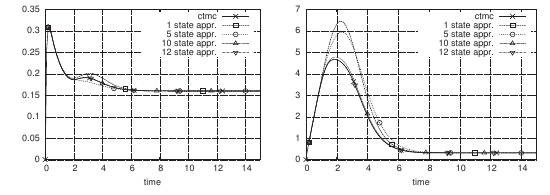
Figure 6: Probability of having one customer and variance of the number of customers at the second station as function of time starting with 10 customers at station 1 with λ = 1 ,μ 1 = 5 ,μ 2 = 5 .